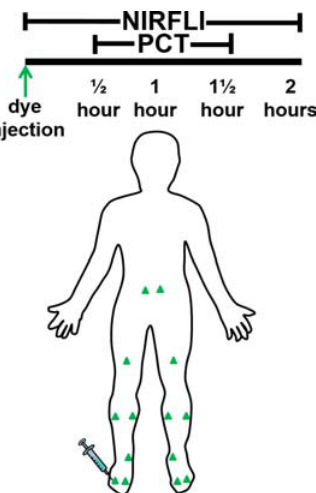
Fig. 1. (Color online) Study logistics. Green triangles indicate ICG injection sites. NIRFLI was conducted for 30 min before donning of Lympha Press PCT garment. NIRFLI was continued during PCT, which consisted of continuous cycles of 45, 40, 35, and 30 mm Hg for 1 h, starting at trunk, and then moving from lower to upper legs, and, in the case of the pants, the abdomen. PCT garment removal was followed by 30 min of imaging.